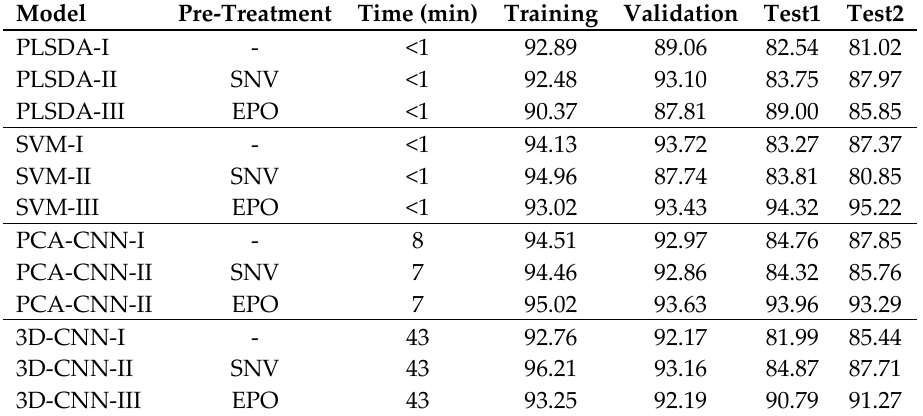
Table 2. Model performance of salmon samples for validation and test images in terms of % correct classification rate (%CCR).